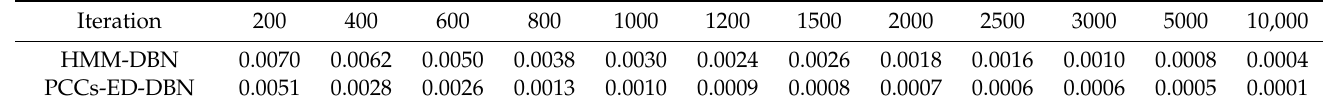
Figure 7. PR-AUC and variance under HMM-DBN and PCCs-ED-DBN. The line graph in panel ( a ) shows the relationship between the network reconstruction accuracy in terms of PR-AUC and the number of MCMC iterations. Line graph in panel ( b ) showing model stability in terms of PR-AUC variance versus number of MCMC iterations. Table 2. The specific value of network structure variance under different models.